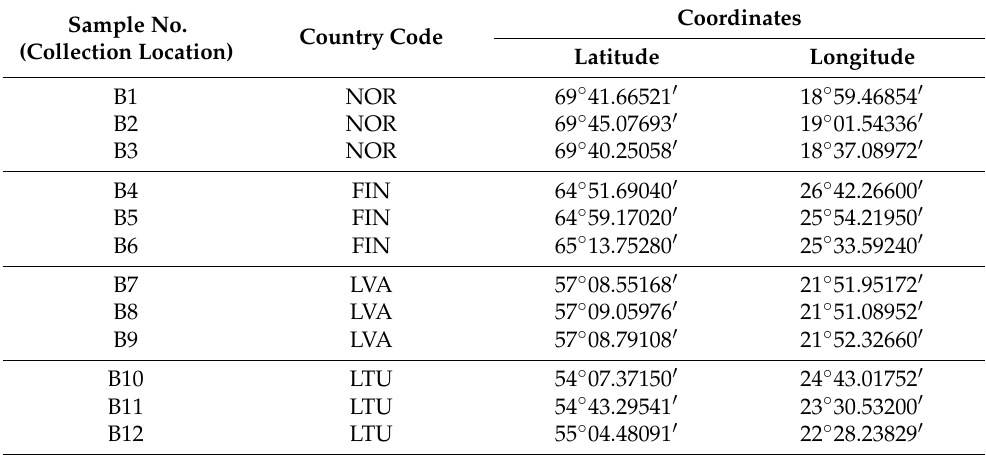
Table 2. Locations of bilberry sample collection in Norway (NOR), Finland (FIN), Latvia (LVA) and Lithuania